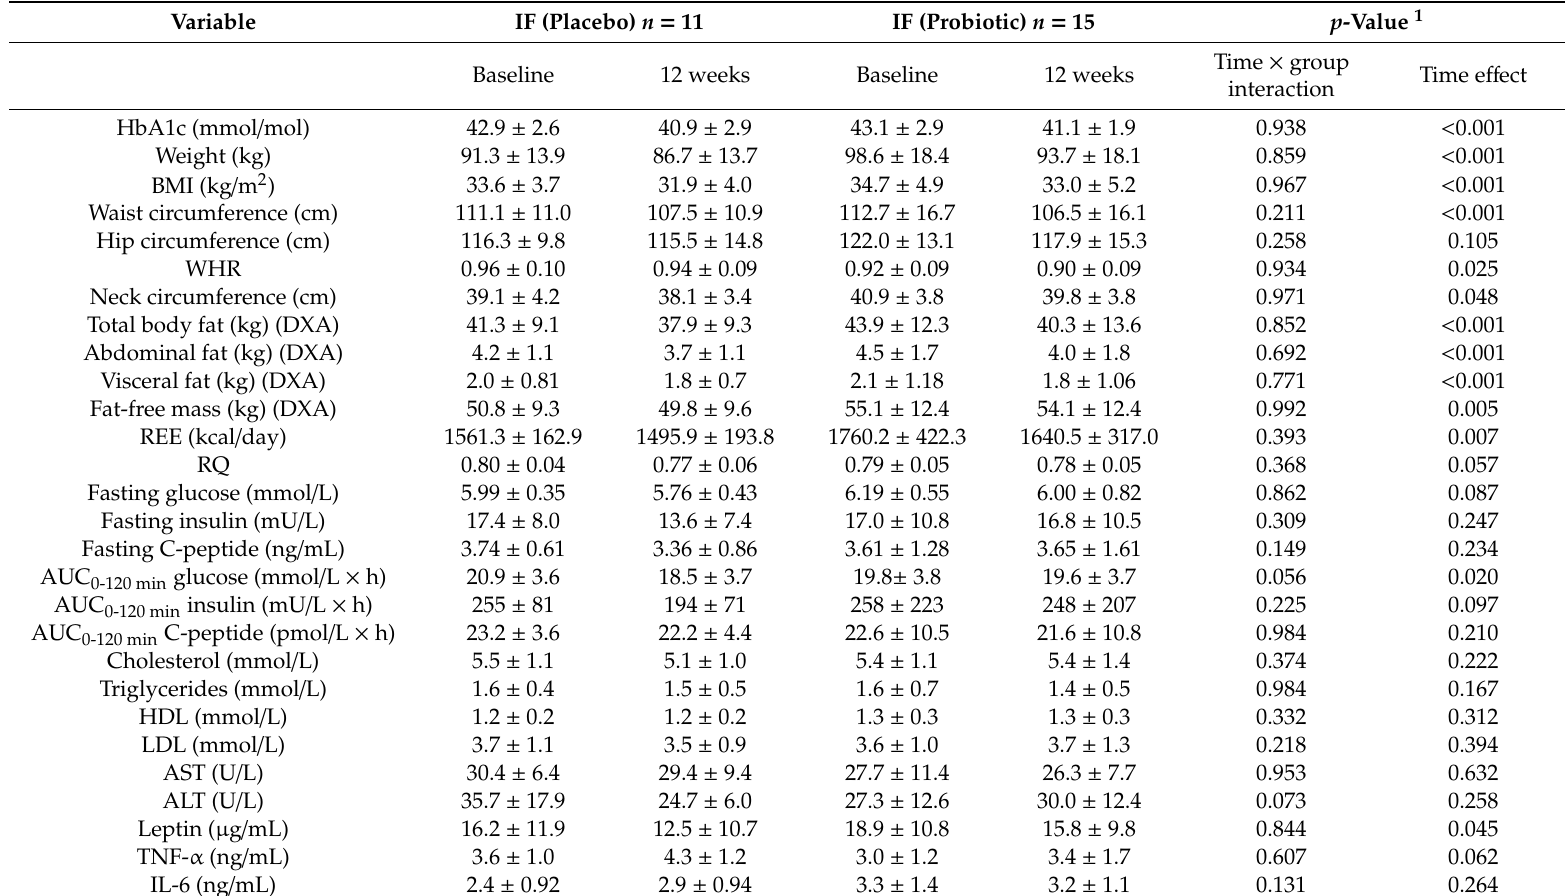
Table 2. Comparison of baseline and post-intervention (12 weeks) results for primary and secondary